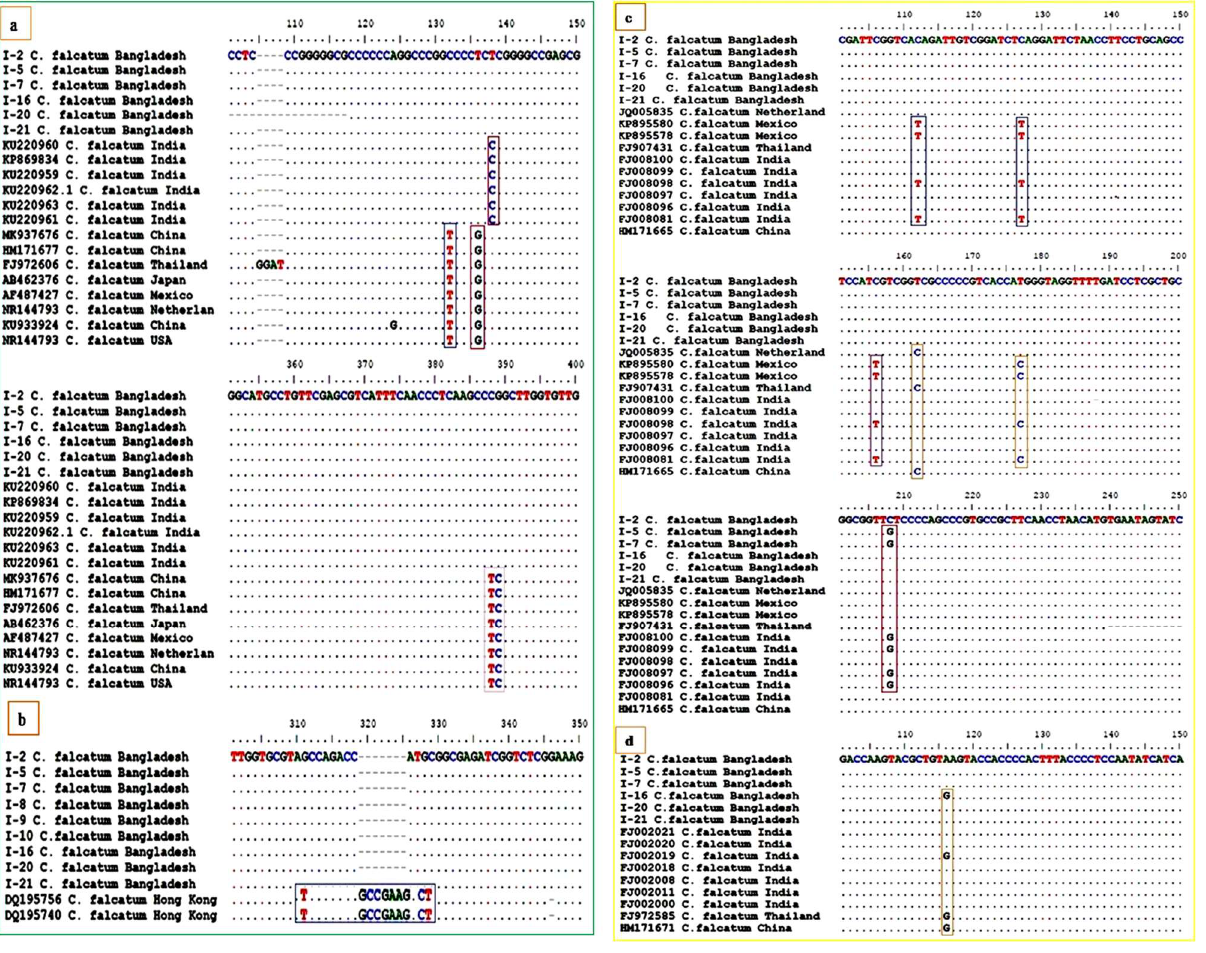
Figure 5. Nucleotides variation of C. falcatum isolates from Bangladesh compare with other countries isolates at different loci positions using ( a ) ITS ( b ) β- tubulin gene ( c ) Actin and ( d ) GADHP gene sequences.